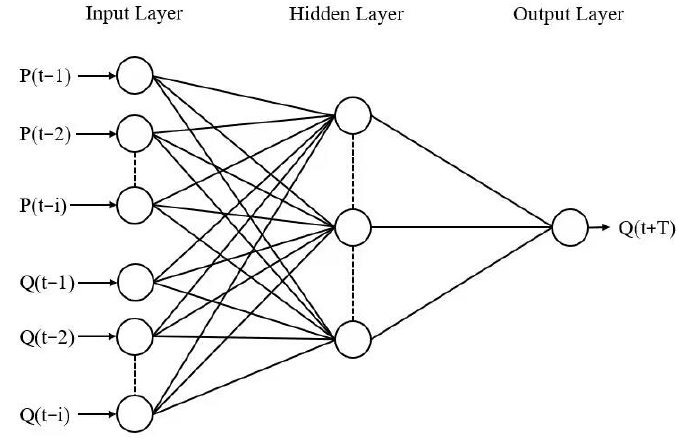
Figure 3. Structure of back-propagation (BP) neural networks.